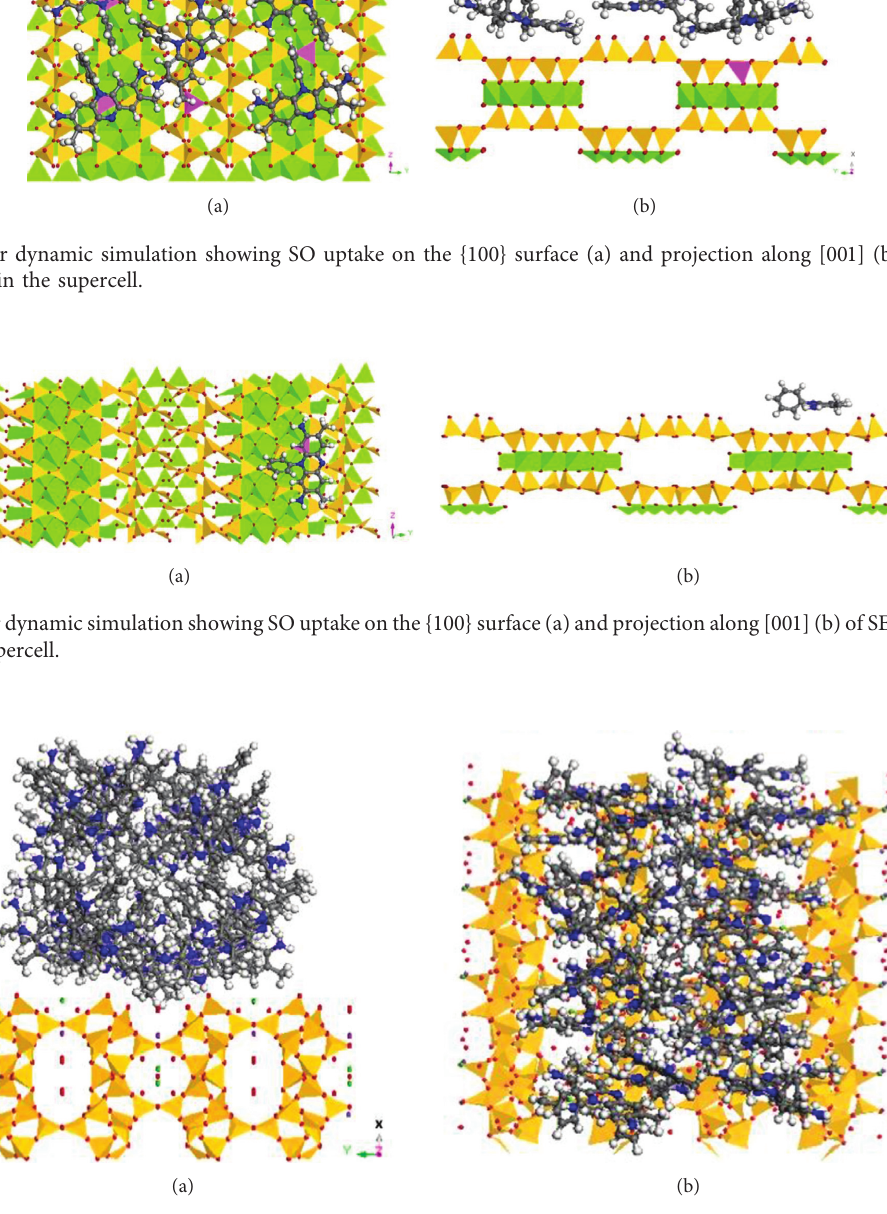
Figure 9: Molecular dynamic simulation showing SO uptake on the {100} surface (a) and projection along [100] (b) of ZEO. Supercell is made of 2 bx 4 c .